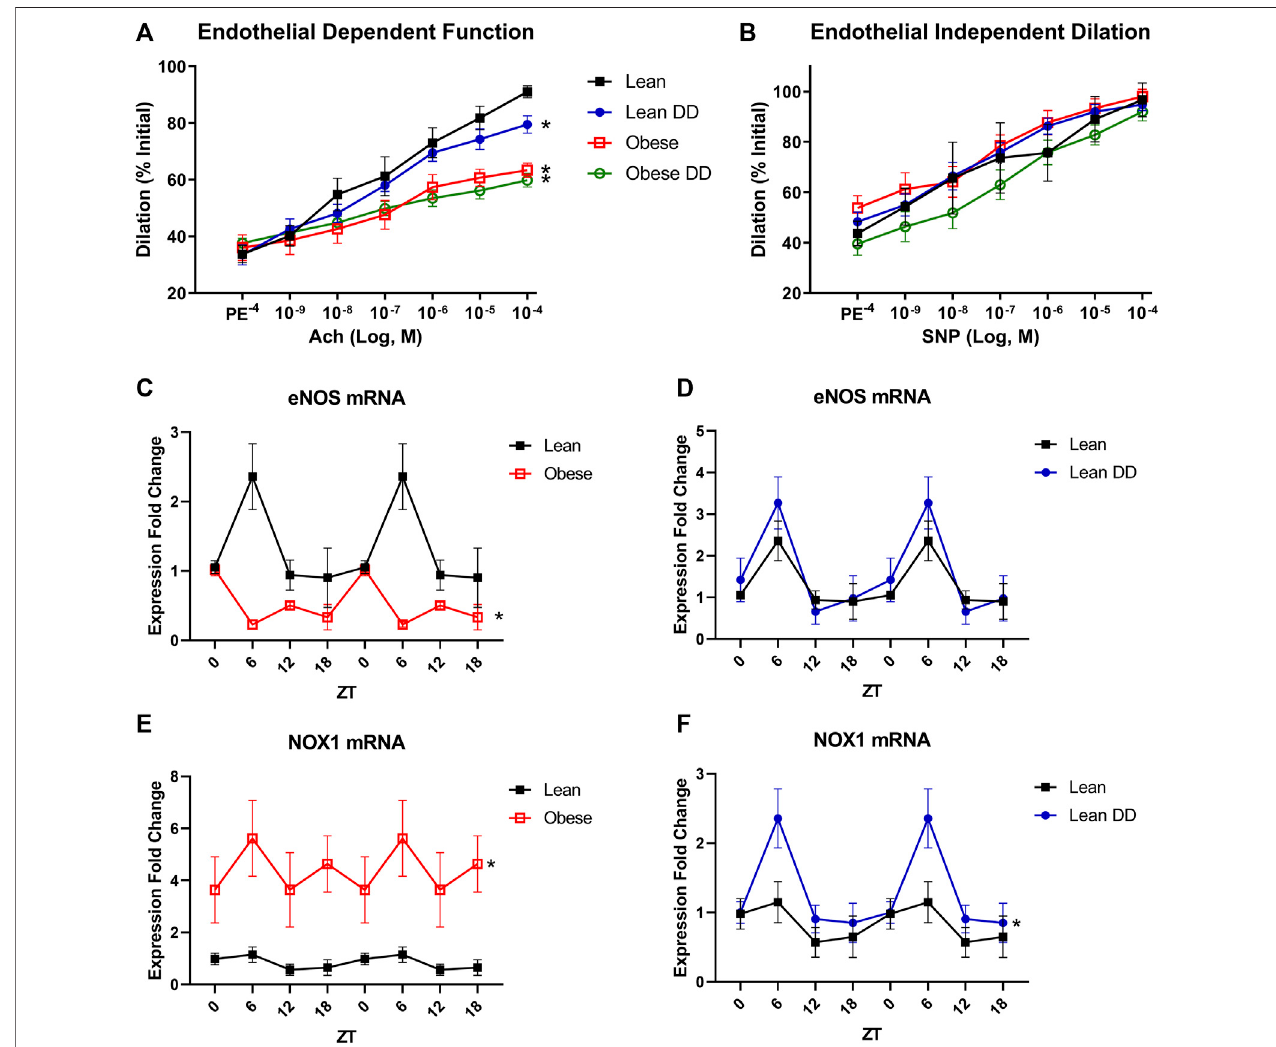
FIGURE 2 | Obesity causes disruption of endothelial cell circadian rhythm and subsequent microvascular dysfunction. (A). Vasodilation (calculated as percent of initialrestingdiameter)todose-responsecurveofacetylcholineinmale20-weekoldlean( db/+ )andobese( db/db )micewithandwithoutexposuretoconstantdarkness ( n = 4 – 6, one-way ANOVA). (B). Vasodilation (calculated as percent of initial resting diameter) to dose-response curve of sodium nitroprusside in male 20-week old lean ( db/+ ) and obese ( db/db ) mice with and without exposure to constant darkness ( n = 4 – 6, one-way ANOVA). (C). eNOS mRNA levels in freshly isolated mesenteric endothelial cells from male 20-week old lean ( db/+ ) and obese ( db/db ) mice ( n = 3 – 6). (D). eNOS mRNA levels in freshly isolated mesenteric endothelial cells from male 20-weekoldlean( db/+ )micewithorwithoutcircadiandisruption( n =3 – 6). (E). NOX1mRNAlevelsinfreshlyisolatedmesentericendothelialcellsfrommale20-weekold lean ( db/+ ) and obese ( db/db ) mice ( n = 3 – 6). (F). NOX1 mRNA levels in freshly isolated mesenteric endothelial cells from male 20-week old lean ( db/+ ) mice with or without circadian disruption ( n = 3 – 6). All data are represented as mean ±